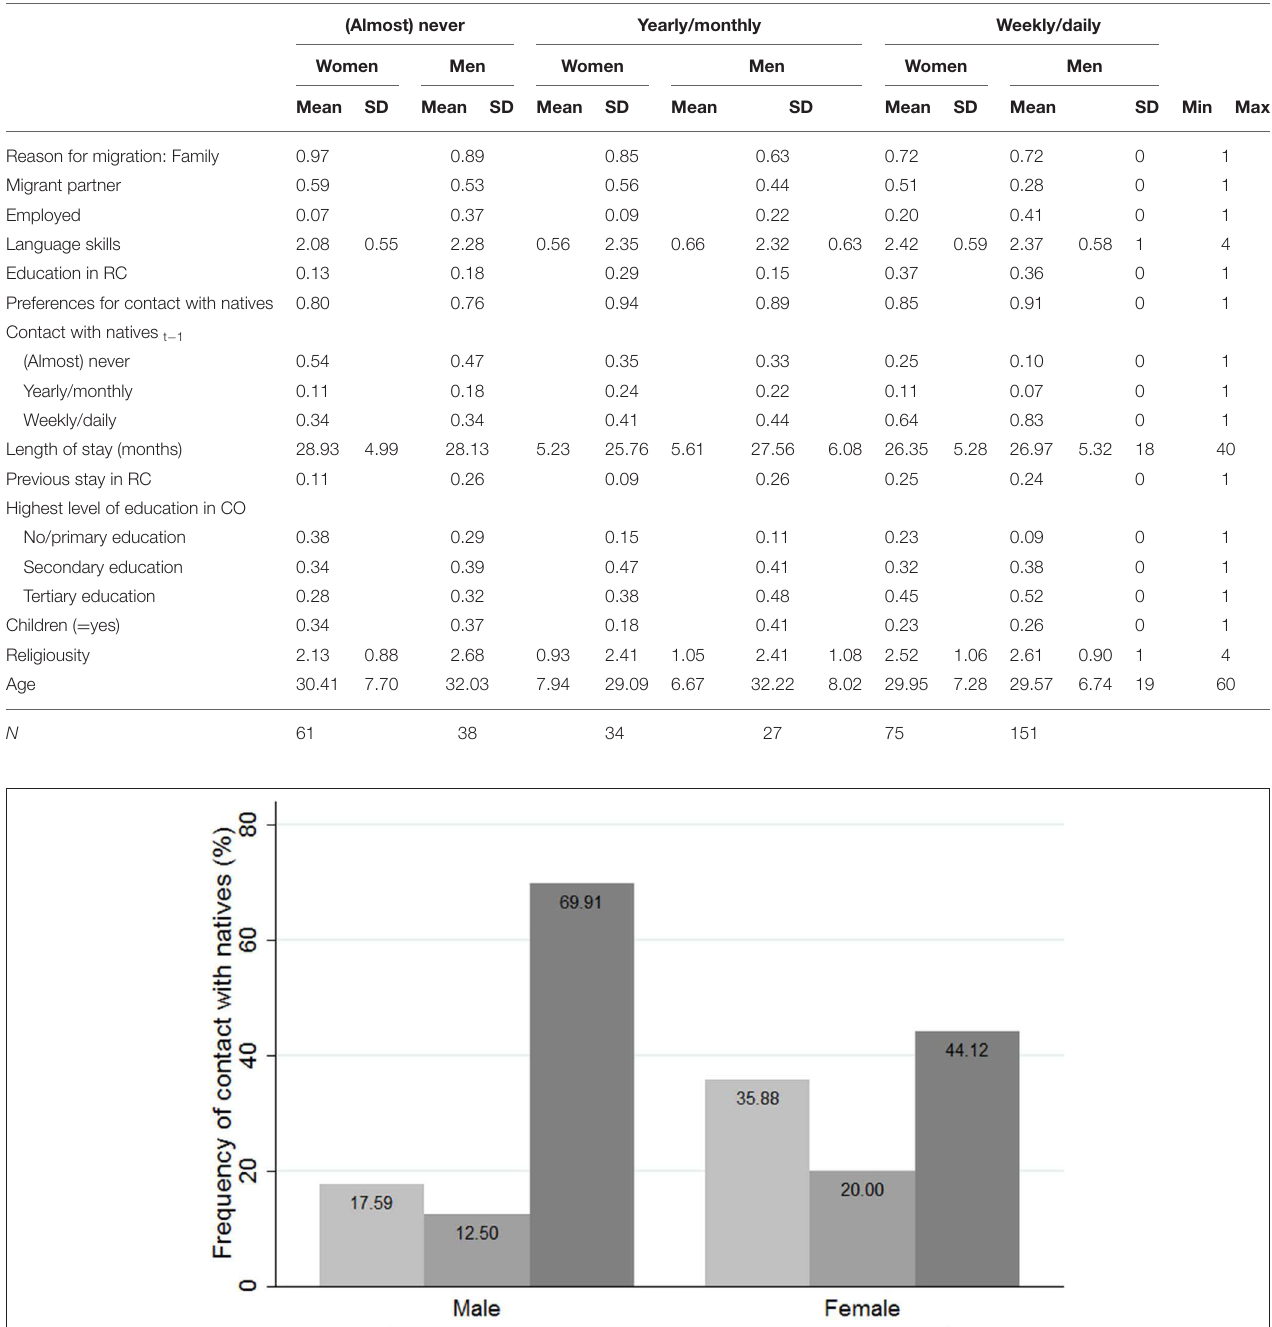
TABLE 1 | Descriptives of main independent variable and control variables, by time spend with natives and gender. (Almost) never Yearly/monthly Weekly/daily